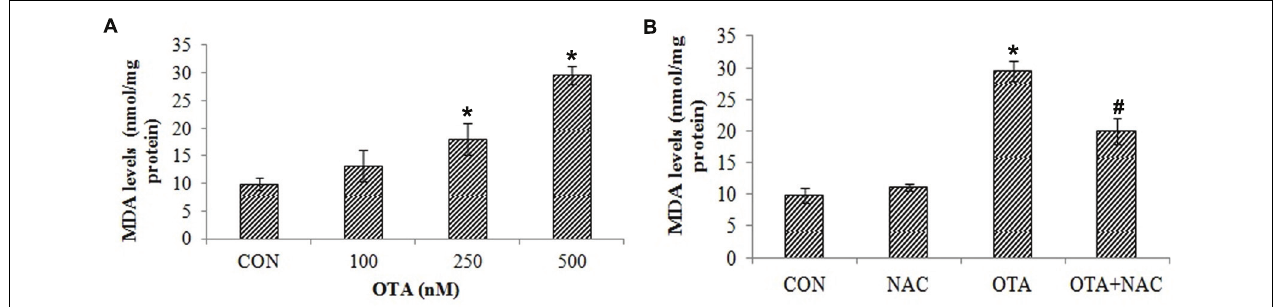
FIGURE 4 | Effect of OTA treatment on lipid peroxidation and protective role of NAC aginst OTA treatment in Neuro-2a cells. (A) Neuro-2a cells were treated with various concentrations of OTA (100–500 nM) for 24 h. Hydroperoxide levels were monitored by using thiobarbuturic acid (B) . Neuro-2a cells were pretreated with NAC (1 mM) for 24 h followed by OTA (500 nM) treatment for 24 h and amount of MDA product formed was assessed. The data represented as mean ± SEM of three independent experiments. ∗ p < 0.05 versus respective control group and # p < 0.05 versus respective OTA treated group.